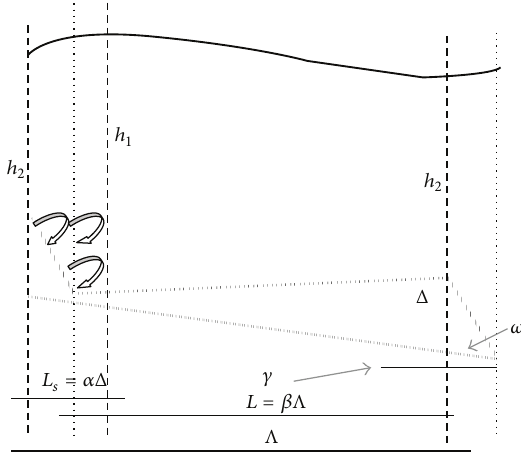
Figure 1: Sketch of the physical model.